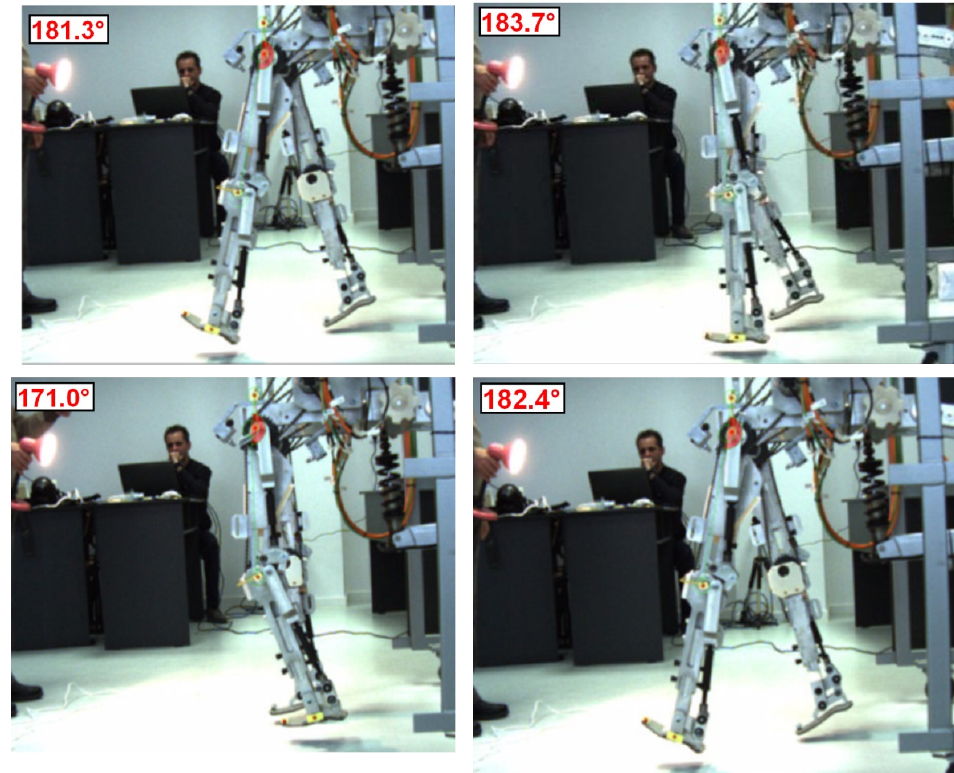
Figure 24. Snapshots during exoskeleton left ankle joints without foot and ground contact.